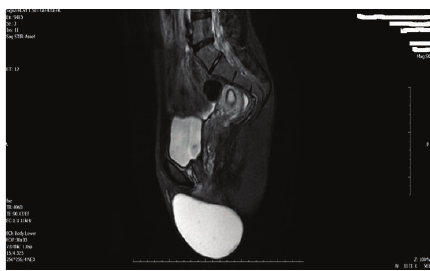
Figure 2: MRI image of 11 × 8 × 10cm cystic mass with well-defined margins and without contrast enhancement.